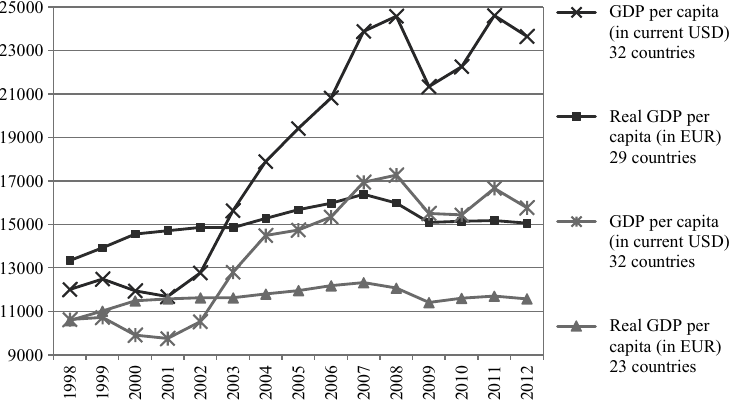
Fig. 1. Standard deviation of GDP per capita in groups of European countries Note: for information on which countries belong to which group see Appendix Table A1. Source : Own calculations based on data from: World Development Indicators / The World Bank / UN database and Eurostat Database / Economy and finance / National accounts (including GDP) / Auxiliary indicators to National Accounts – annual data / GDP per capita – annual